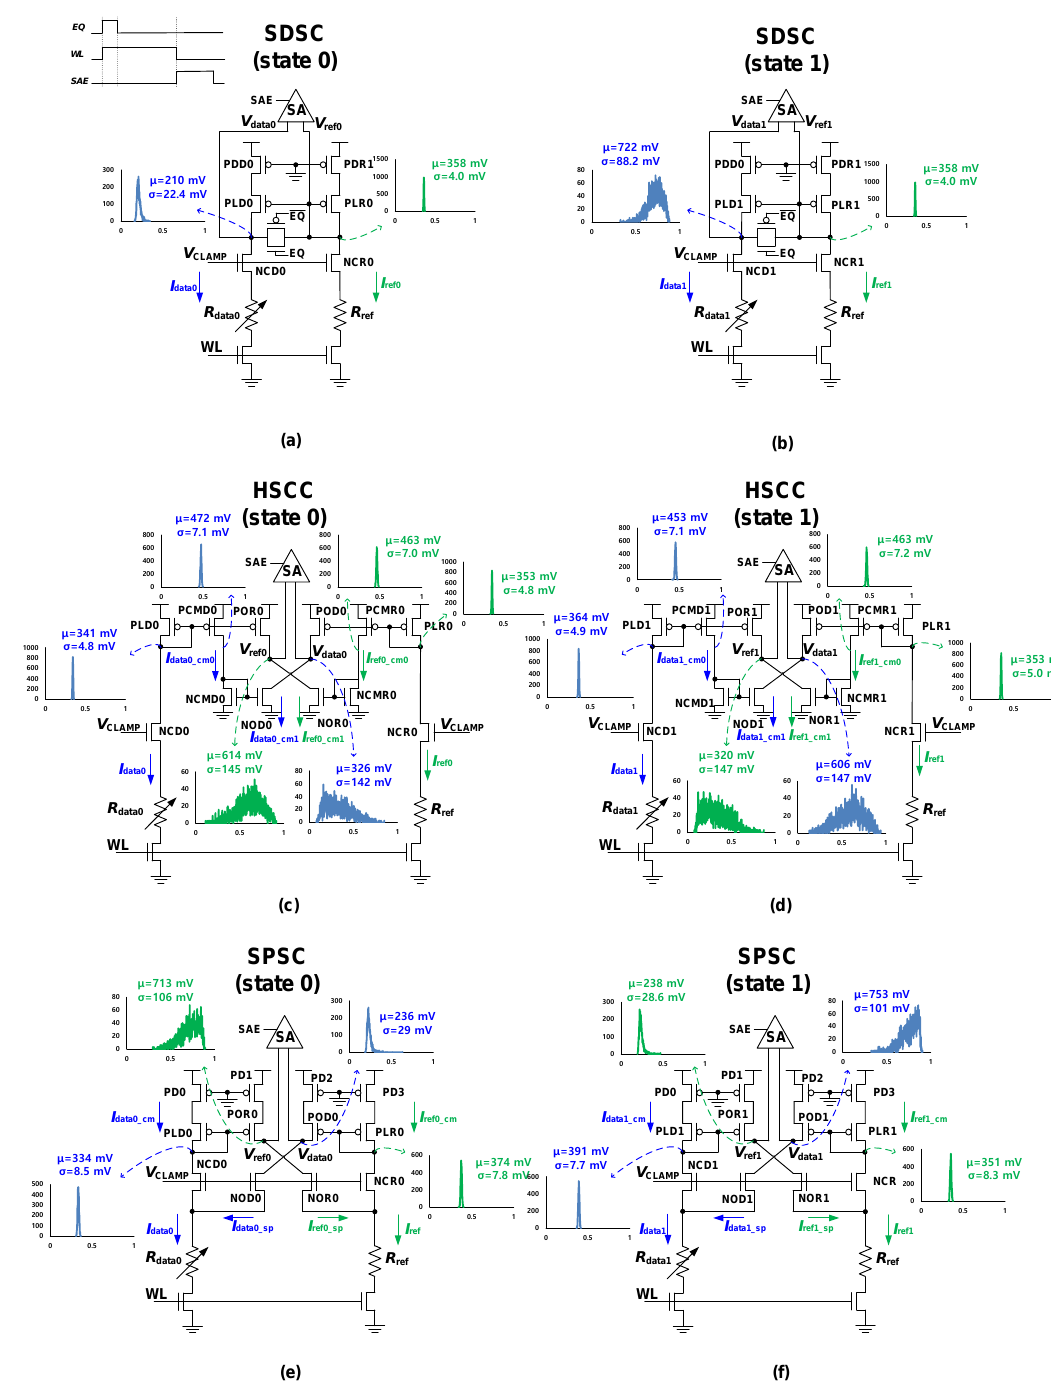
Figure 1. Schematics of conventional SCs with voltage distributions and timing diagrams. ( a ) SDSC [11] at state 0; ( b ) SDSC at state 1; ( c ) HSCC [13] at state 0; ( d ) HSCC at state 1; ( e ) SPSC [10] at state 0; ( f ) SPSC at state 1.